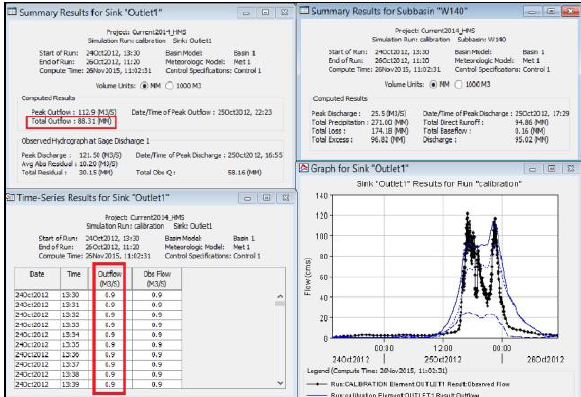
Figure 7. HEC-HMS results with the generated rainfall-runoff curve